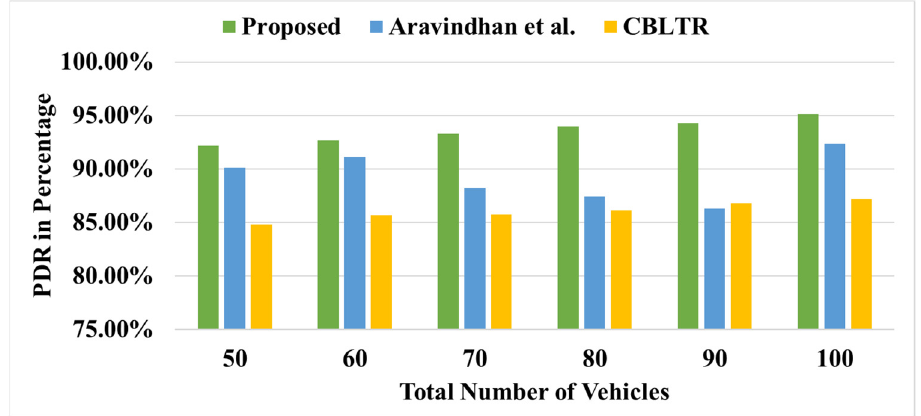
Figure 8. Comparison of results of the proposed system and existing systems (Aravindhan et al. [24] and CBLTR [21]) on PDR versus vehicular nodes in 1500 × 1500. Average E2E delay is the average duration taken by a data packet to communicate between the source and destination. Tables 7 and 8 show the delay comparison with var- ying vehicle nodes for the proposed Aravindhan et al. [24] and CBLTR [21] protocols in network areas 1000 × 1000 and 1500 × 1500, respectively. In VANETs, the probability of connection and data packet delay also increases with an increase in the node ’ s distance.